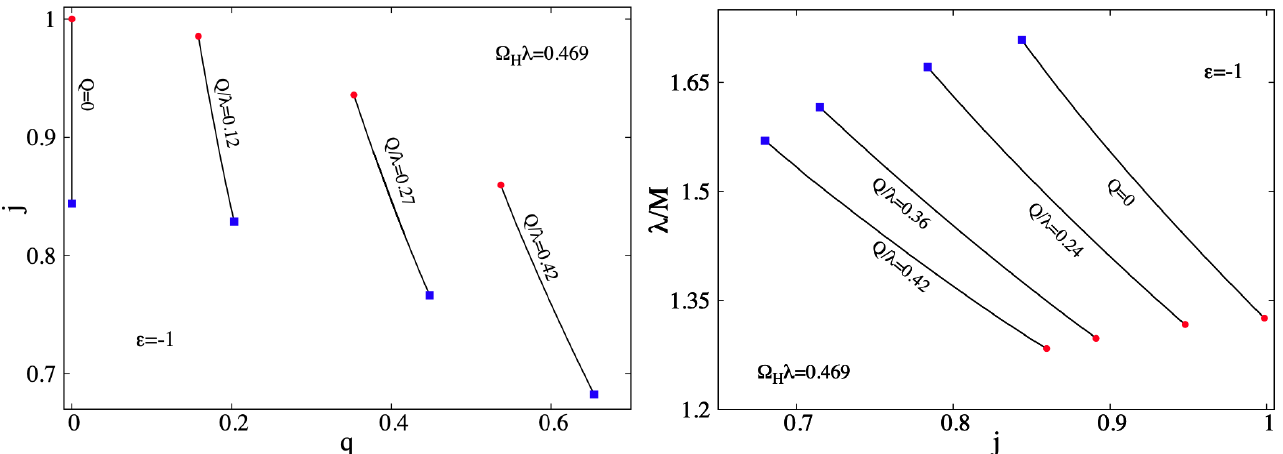
Figure 5. Branches of GB − scalarised Kerr-Newman BHs in a q vs. j plot ( left panel ) and j vs. λ / M plot ( right panel ). The branches are for a specific choice of Ω H λ = 0.469 and different choices of Q / λ . The blue squares correspond to Kerr-Newman BHs with a vanishing scalar field, while the red circles correspond to critical